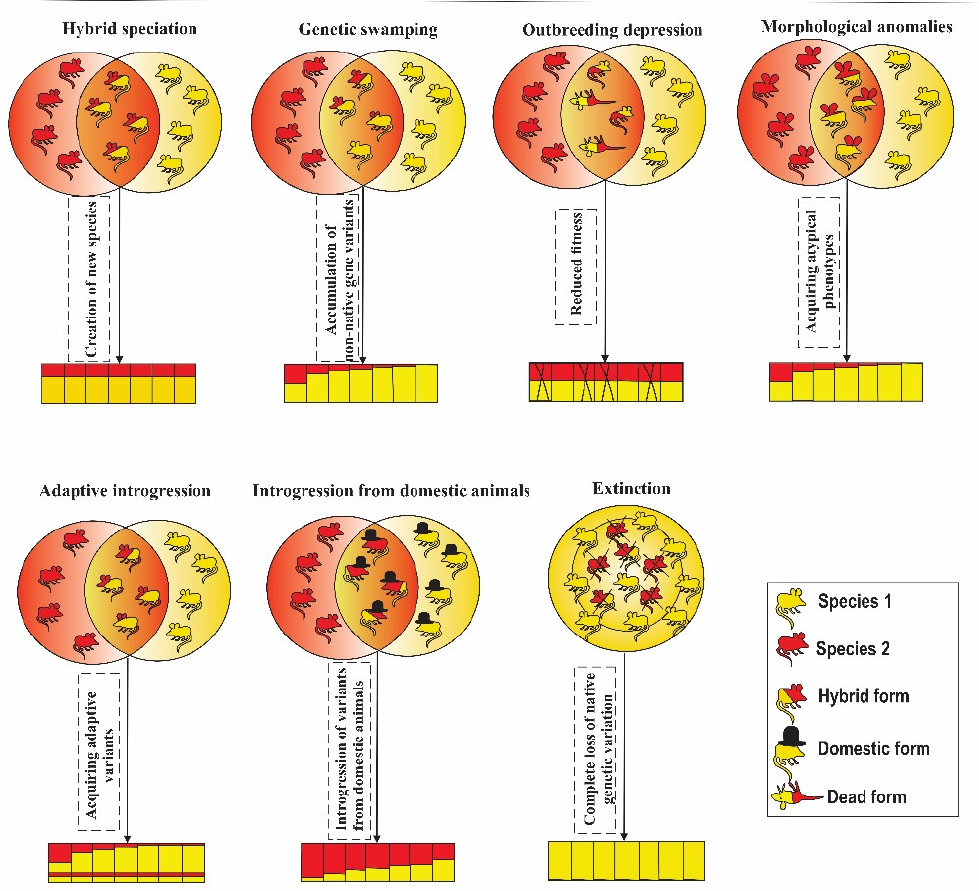
Figure 3. Graphical representation of the common outcomes of hybridization.